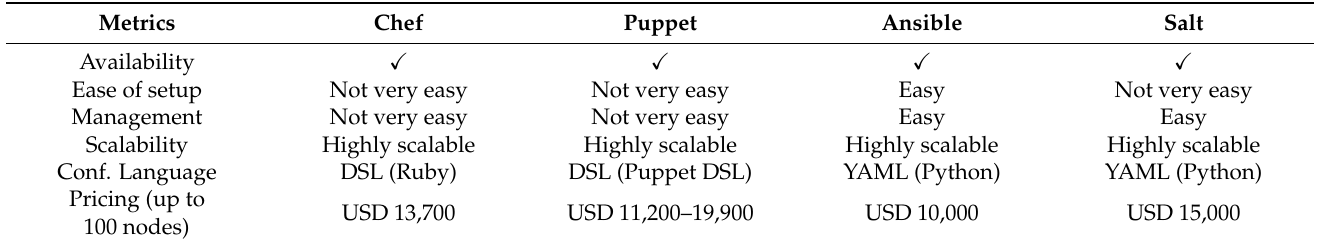
Table 1. Comparison among the key features of the main provisioning tools (extracted from [21]). (cid:88) symbol means that the technology satisfies the